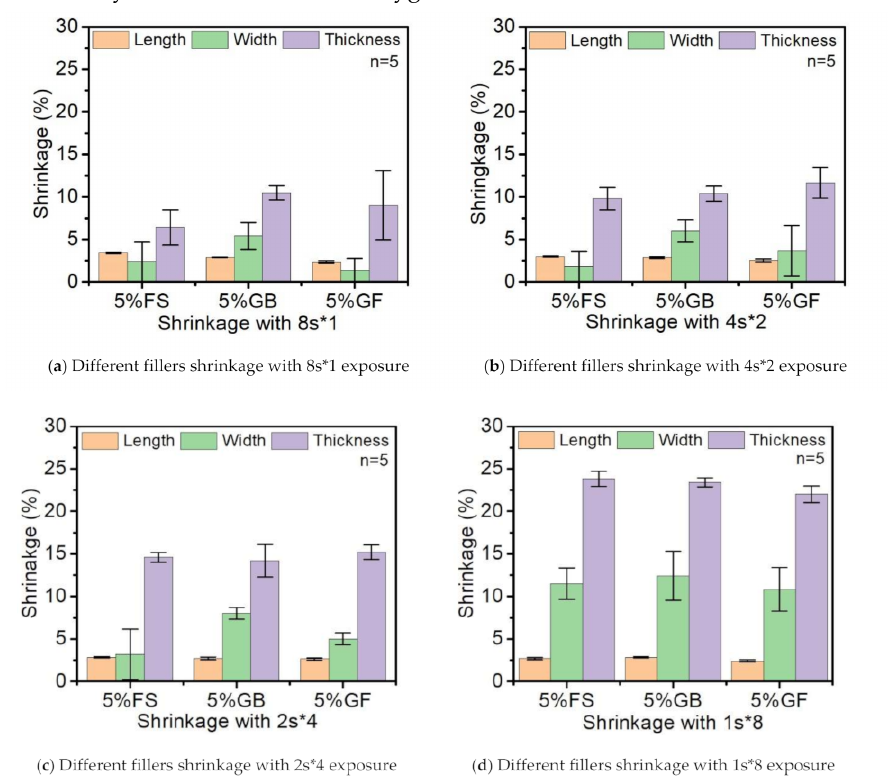
Figure 10. The shrinkage of tensile bar under four curing strategies with different